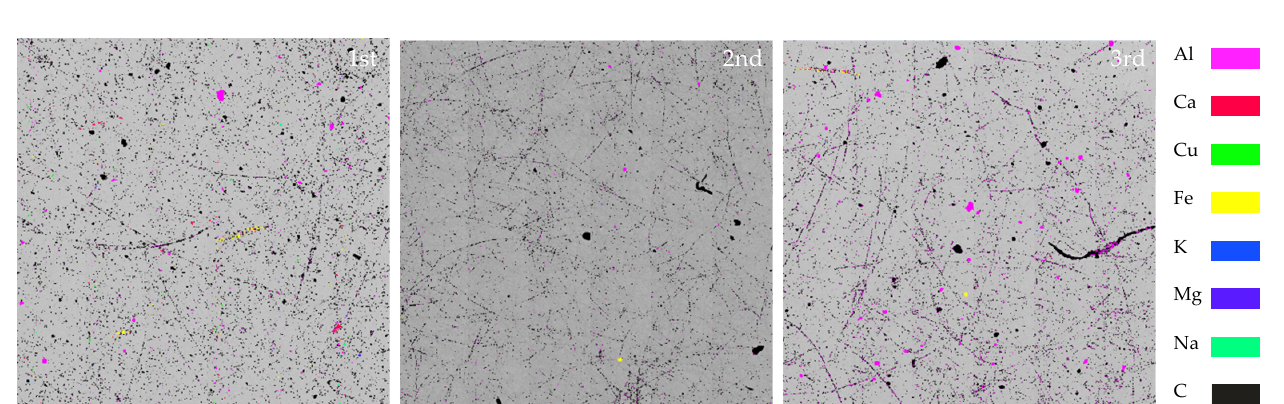
Figure 3. Surface of the 1st, 2nd, and 3rd samples (BSE image). Table 2. Major chemical categories and their normalized average particles (size: 1 μ m < Dp) of metal compound from incineration experiment of waste mulching LDPE collected in DangJin (unit: ea).